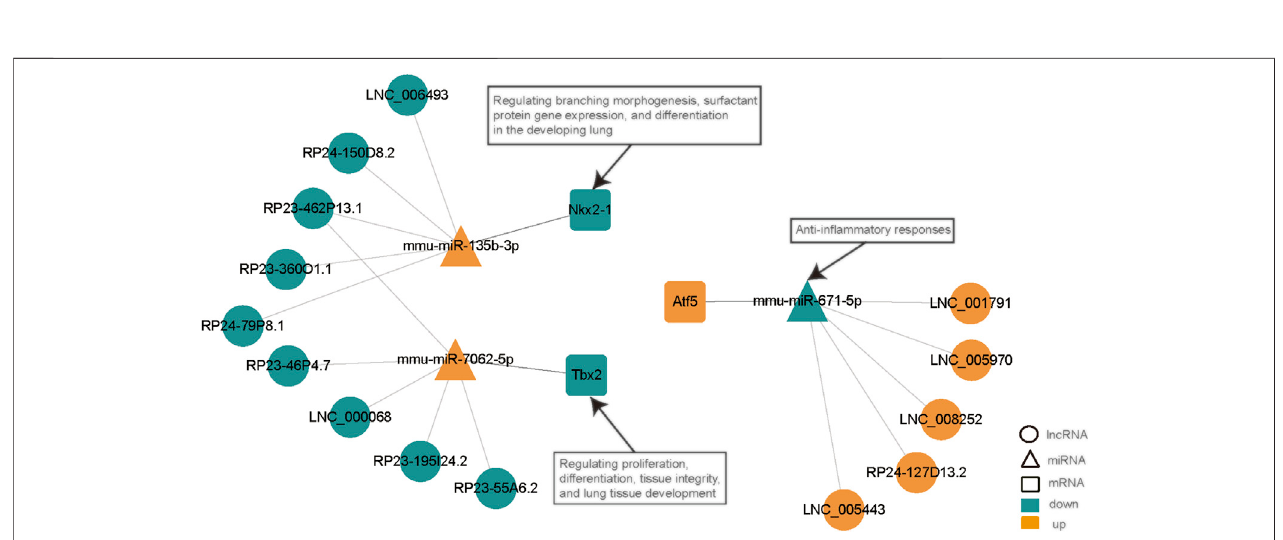
FIGURE 8 | LncRNA-miRNA-hub gene network. This network, constituting 15 lncRNAs, 3 miRNAs, and 3 hub genes, was generated with Cytoscape (3.8.0). Ellipse, lncRNA;triangle,miRNA; rounded rectangle,mRNA. Rednodes, upregulation; darkgreennodes, downregulation. LPS, lipopolysaccharide;ceRNA, competing endogenous RNA; NS, no lipopolysaccharide; lncRNA, long non-coding RNA; DE, differentially expressed; miRNA,